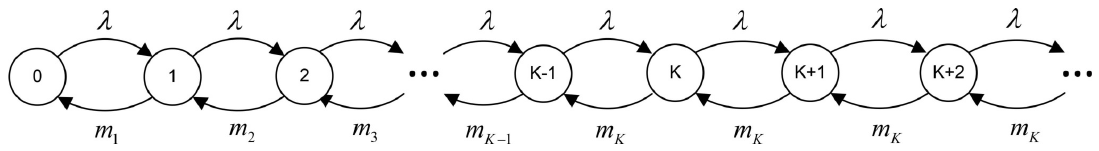
Figure 6. The state transition diagram for the queueing system S u